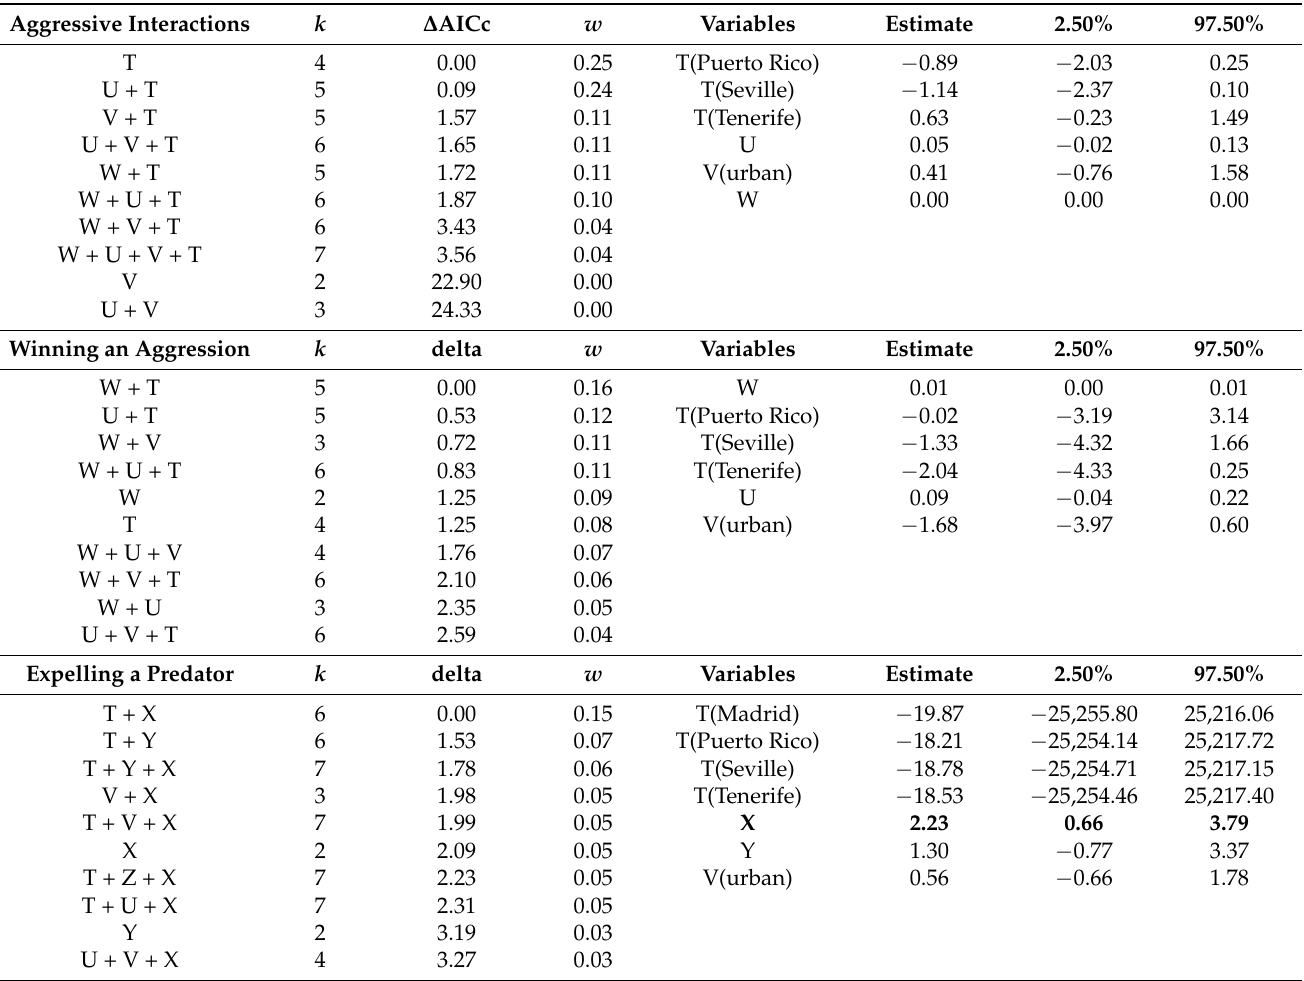
Table 4. Models obtained to assess factors involved in the probability of developing aggressive interactions or winning them when monk parakeets interacted with their tenants and in the probability of expelling predators through aggressive interactions. Estimates and 95% confidence intervals (2.5% and 97.5%) were obtained after model averaging. k : number of parameters, ∆ AICc: difference between the AICc (i.e., the Akaike Information Criterion corrected for small sample sizes) of model i and that of the best model (i.e., the model with the lowest AICc), w : Akaike weights. The fit of the model including all variables used in model averaging can be checked in Figure S1. In bold, variables receiving strong support (i.e., the 95% confidence interval did not overlap with zero). The first ten models obtained are